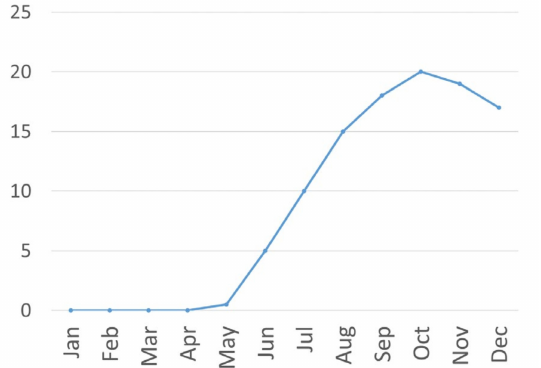
Figure 2. Monthly yield rates for Miscanthus